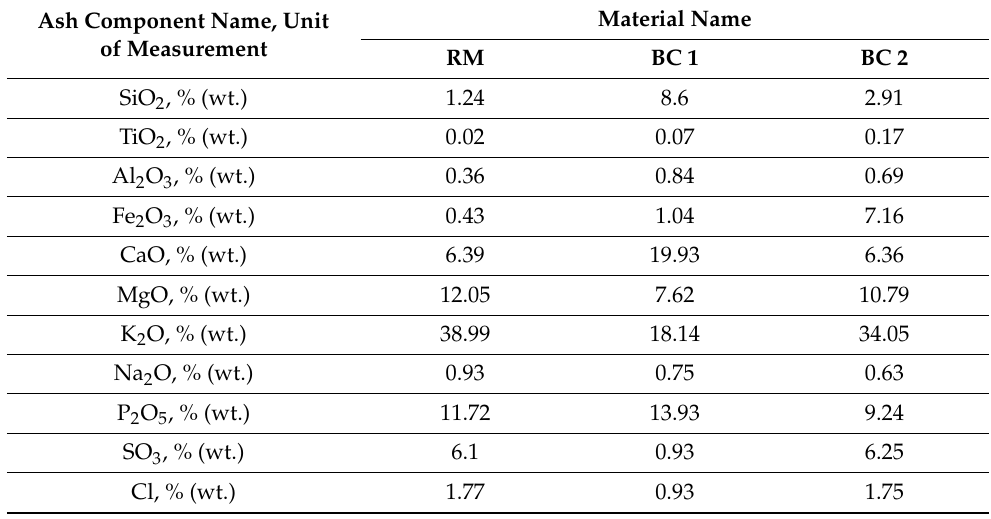
Table 5. Chemical composition (on a dry basis) of initial husk ash (RM) and biochar ash (BC 1 and BC 2). Ash Component Name, Unit of Measurement